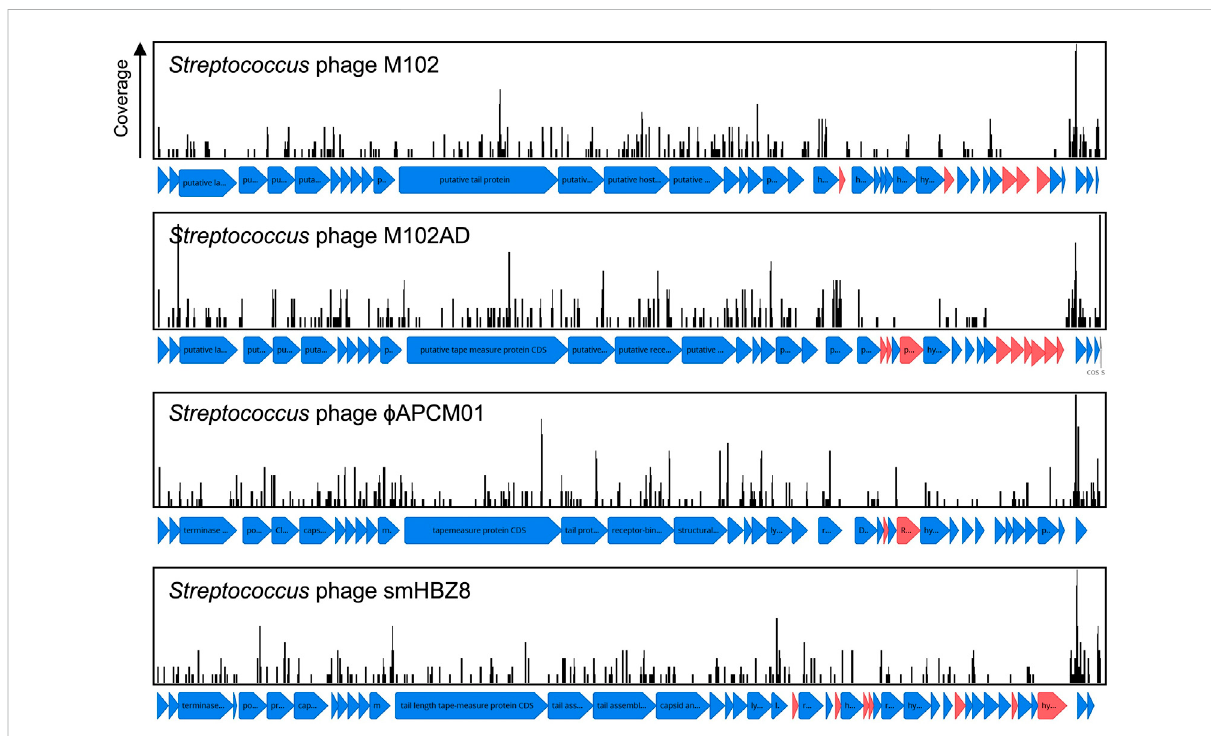
FIGURE 3 CRISPR spacer acquisition against S. mutans bacteriophage. CRISPR spacers were blasted against viral sequences downloaded from NCBI. CRISPR spacers mapped to four S. mutans infecting phage, M102 (371 spacers), M102AD (388 spacers), ɸ APCM01 (354 spacers) and smHBZ8 (362 spacers). These are the only S. mutans phage that have been genome sequenced and all belong to the Siphoviridae family of double-stranded DNA viruses. CRISPR spacers that mapped to phage sequences are shown as black lines, with the height of these lines indicating the total number of spacers that mapped to that speci fi c region. Open reading frames for which no CRISPR spacers have been acquired against are colored red, and are more frequently located in a variable region of the phage